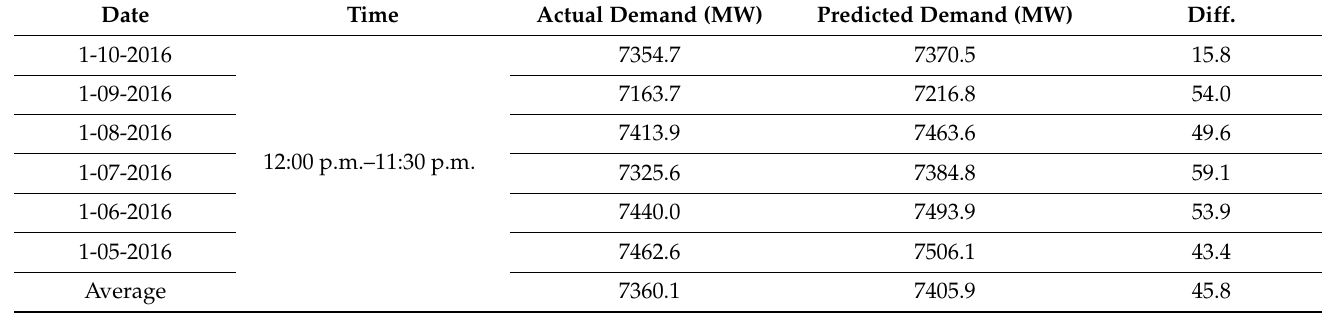
Table 1. Difference between actual and predicted demand for a period of six.